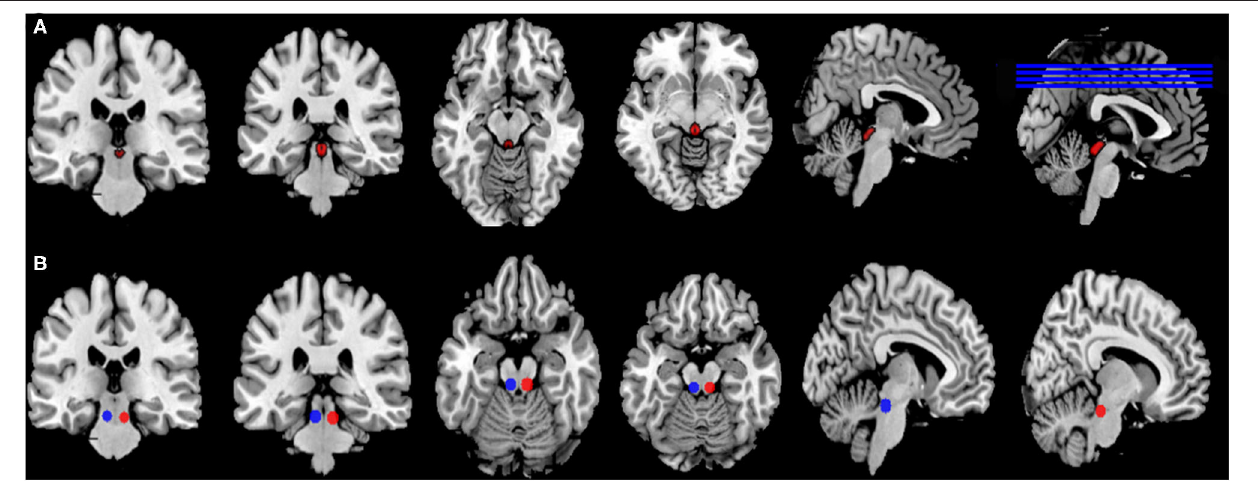
FIGURE 1 | Location of seeds and ROI. (A) The ROI of the PAG was obtained from the Keuken and Forstmann’s 7T atlas that provides ROIs obtained from high-resolution MP2RAGE and FLASH scans warped in MNI space (Keuken and Forstmann, 2015), Available at https://www.nitrc.org/project cts/atag/; (B) The ROI of double PPN was generated by placing two 5mm radius spheres with centers at coordinates [ ± 6.4, − 27, − 15] in MNI standard space.